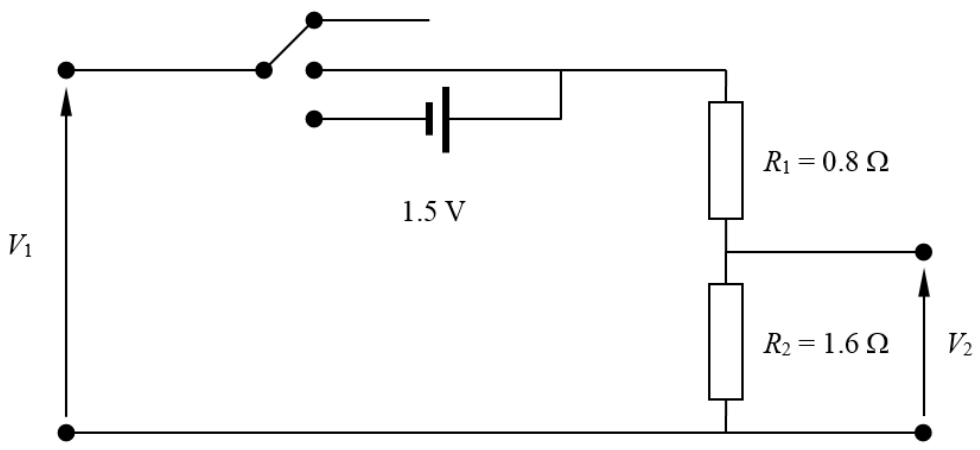
Figure 2. Sketch of the voltage dividers used to enlarge the measuring rang of ABDAS.